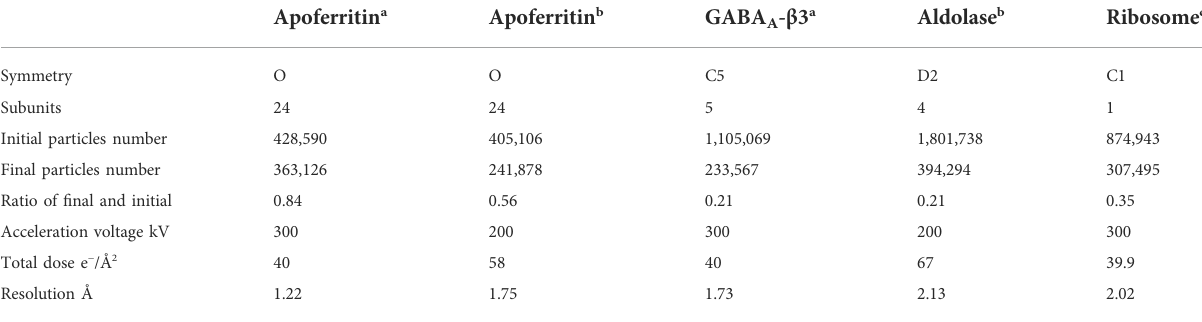
TABLE 2 Single particle data processing